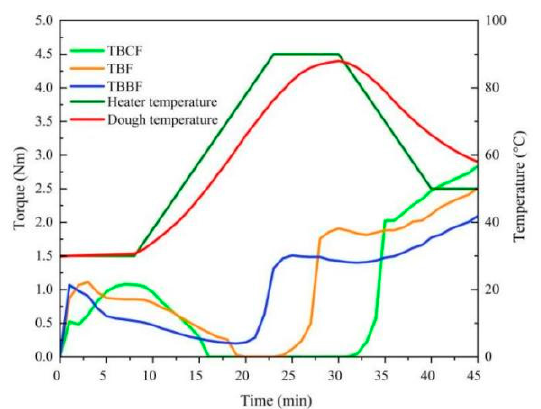
8 of 15 Figure 3. Water absorption index (WAI) and Water soluble index (WSI) of TBF, TBCF and TBBF (TBF: Tartary buckwheat flour; TBCF: Tartary buckwheat core flour; TBBF: Tartary buckwheat bran flour). The dough properties of TBF, TBCF, and TBBF were measured with the Mixolab ® protocol. As shown in Figure 4 and Table 4, different samples had different dough torque curves. At the initial stage, the dough formation time of TBBF was significantly lower than that of TBF and TBCF, which could be due to the fact that its high protein content could accelerate dough formation. During the heating process, the torque C2 values of TBF and TBCF were 0, suggesting that their protein weakening degrees were very large, and the dilution effect caused by them reduced the viscosity of the dough. The hardness and stick-